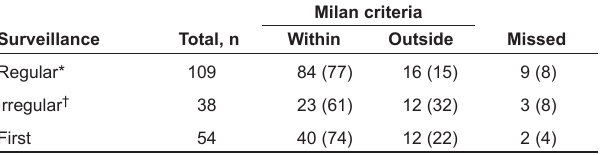
TABlE 2 Comparison of surveillance interval using Milan criteria for liver transplantation Surveillance